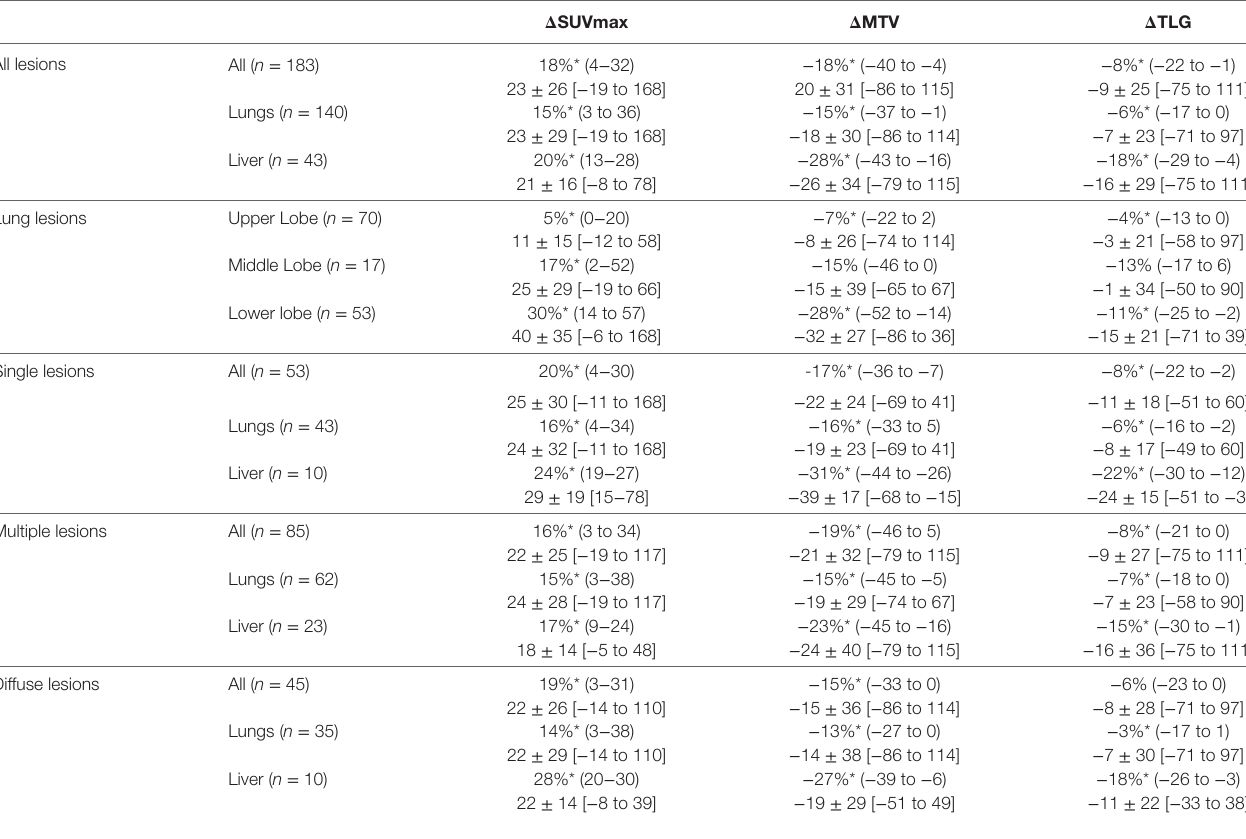
Table 2 | All lesions results, lung lesions results, and patients analysis results expressed as median (Q1 − Q3), and mean ± SD [min–max]; *: statistically significant difference ( p <